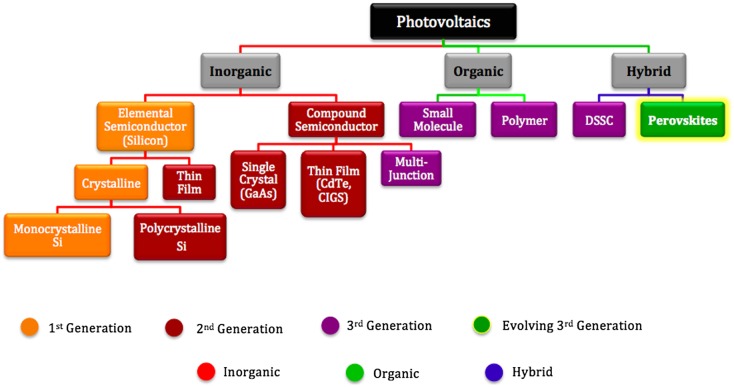
Taxonomy of PV technologies. Adapted from [13].